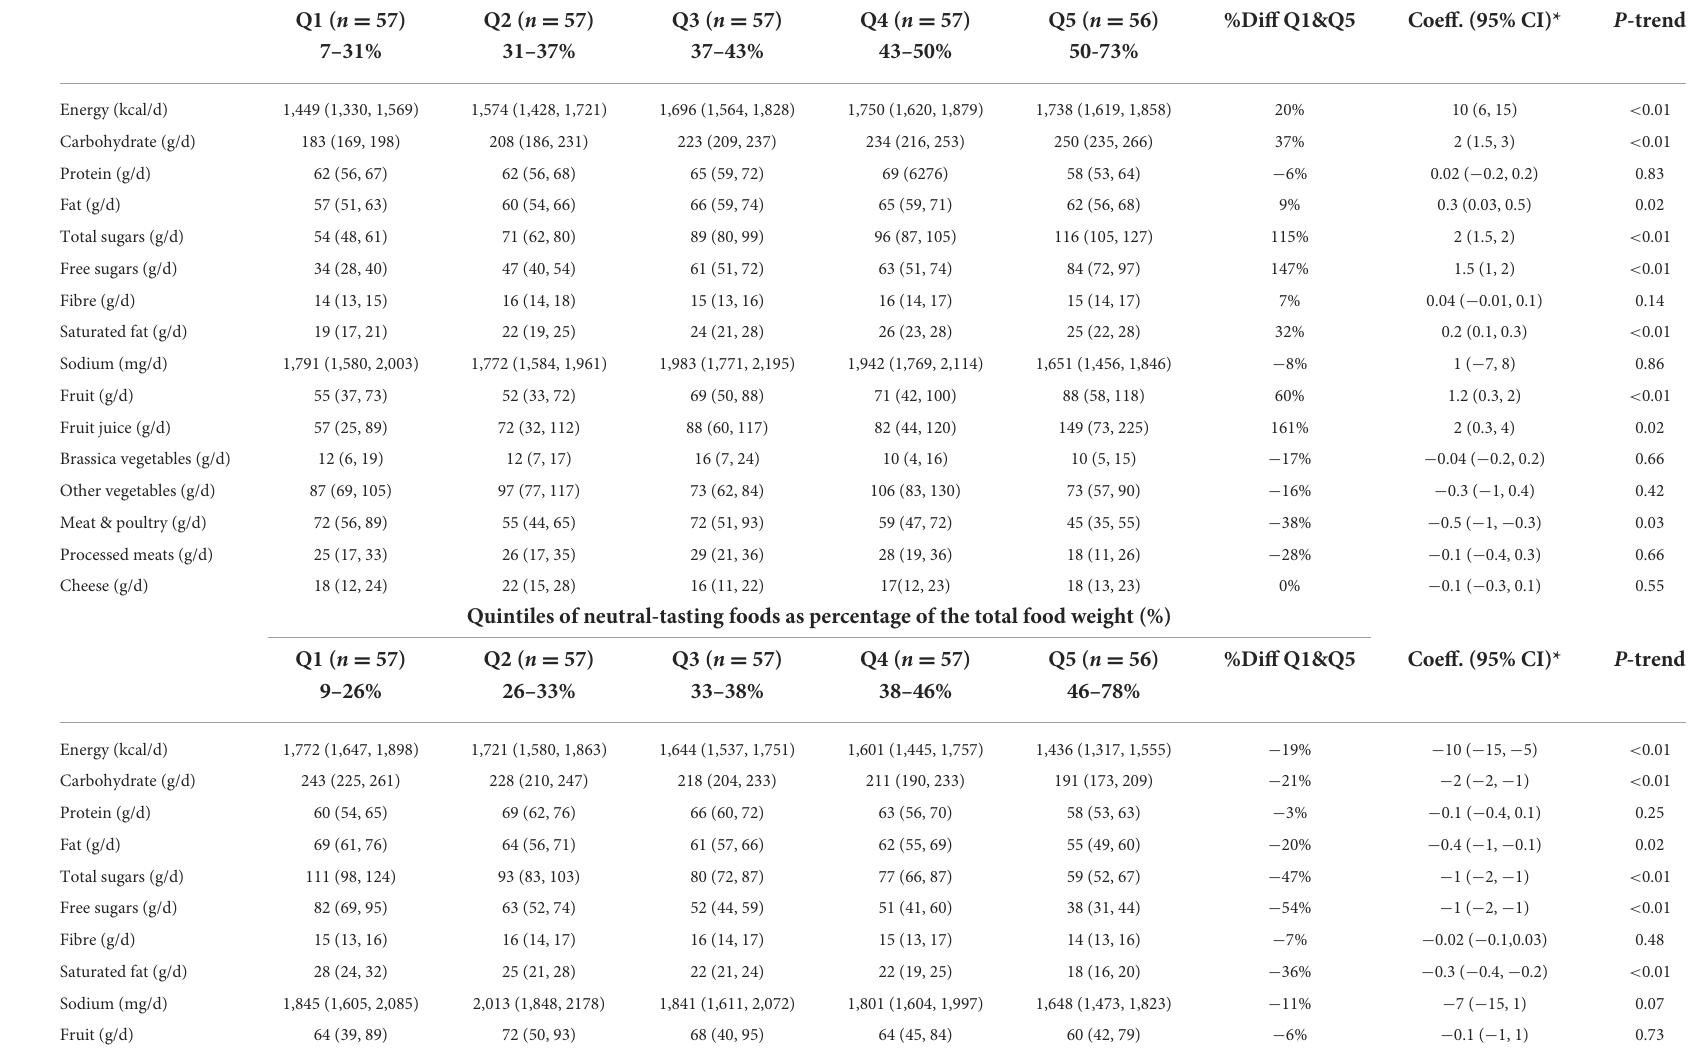
TABLE 2 Characteristics of adolescents’ dietary intakes by the quintiles (Q) weight of foods consumed as a percentage of the total food weight. Quintiles of sweet-tasting foods as percentage of the total food weight